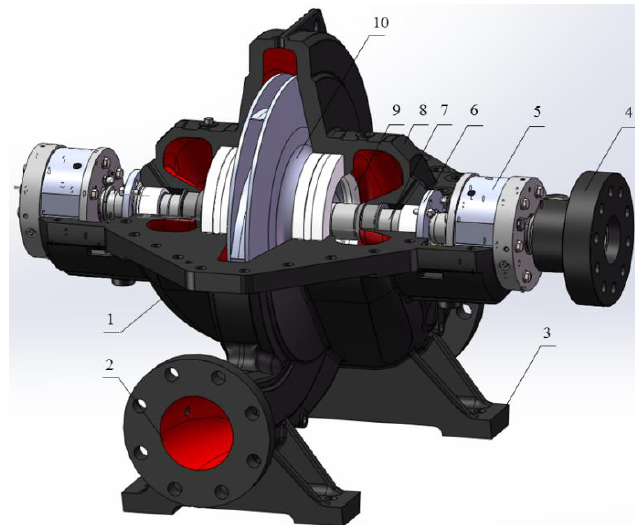
Figure 3. Three-dimensional structure of the research object: 1—Pump body; 2—Outlet; 3—Base; 4—Coupler; 5—Rolling bearing; 6—Mechanical seal; 7—Main shaft; 8—Pump cover; 9—Sealing ring; 10—Impeller.